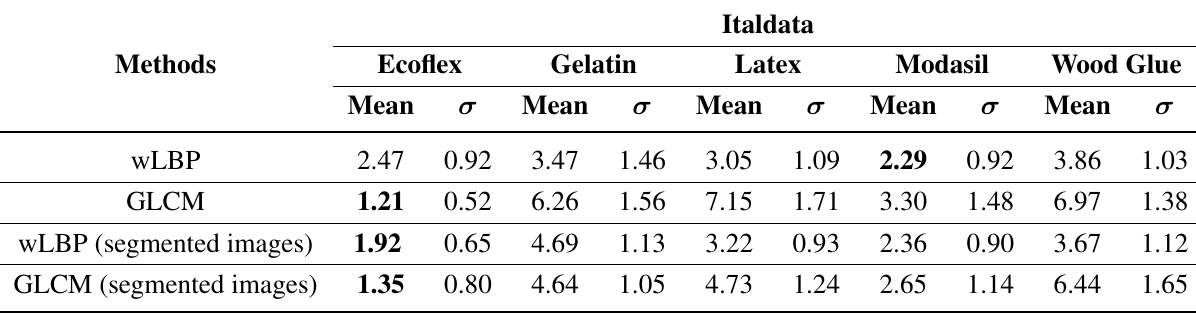
Table 4. ACER for each material of the Italdata dataset, study 1 (ACER in % ).